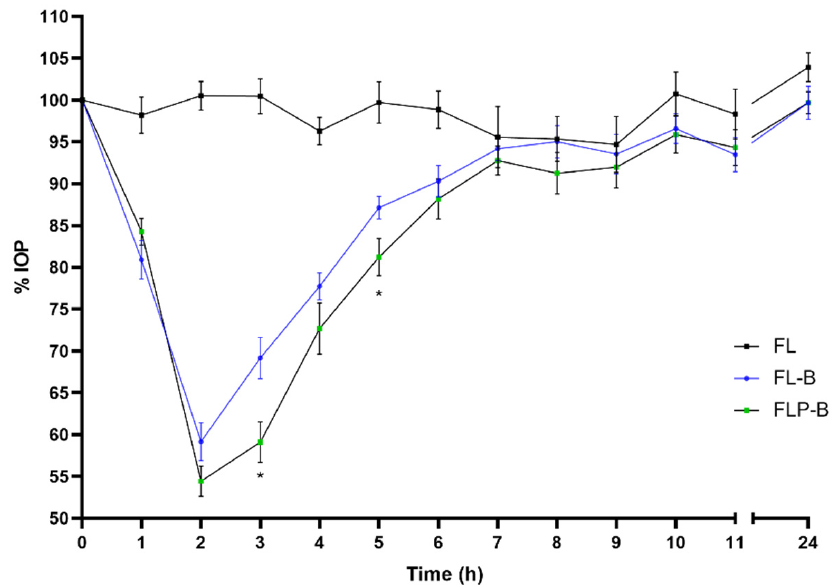
Figure 7. Decrease in intraocular pressure after administration of the liposomal formulation con- taining brimonidine and HPMC (0–24 h), with statistical significance between FL-B and FLP-B formulations (* p < 0.05).